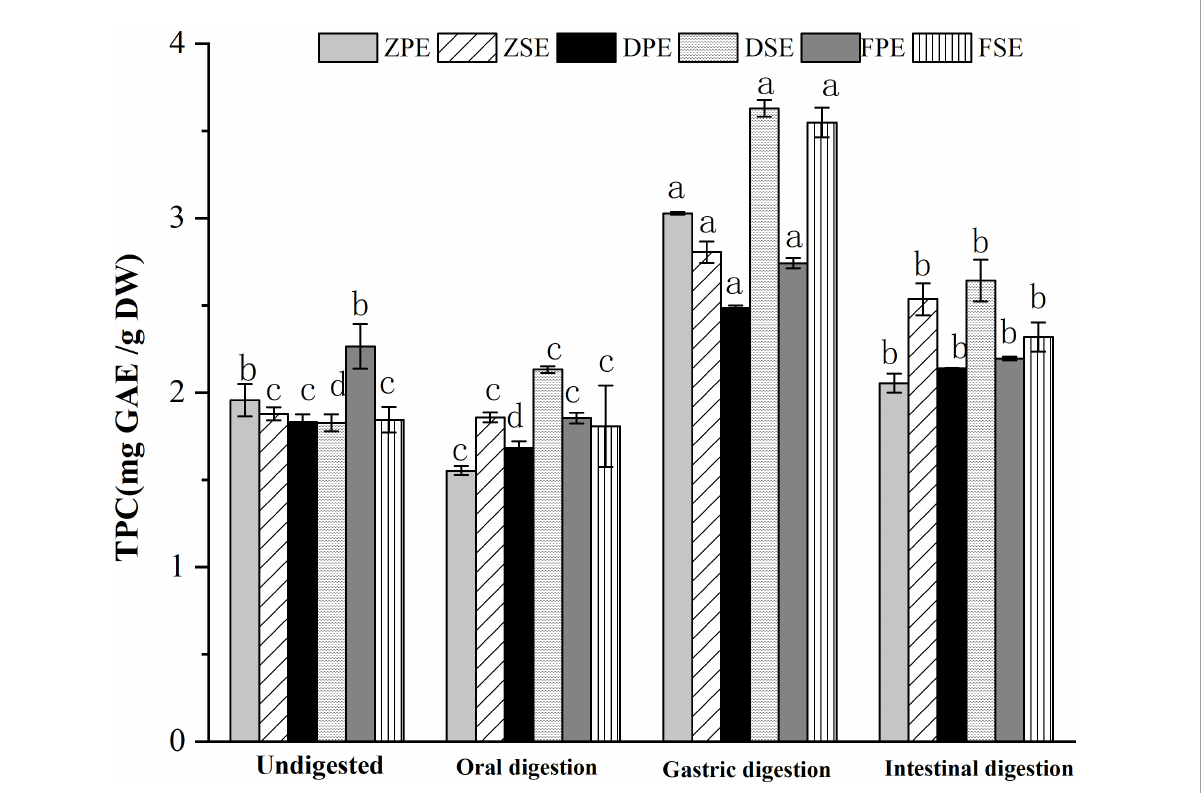
FIGURE1 The changes of TPC in the peel and sarcocarp of Kadsura coccinea fruits during simulated in vitro digestion. Values are presented as means ± SD ( n = 3), ( p < 0.05). ZPE, Zihei peel extract; DPE, Dahong peel extract; FPE, Fenhong peel extract; ZSE, Zihei sarcocarp extract, DSE, Dahong sarcocarp extract; FSE, Fenhong sarcocarp